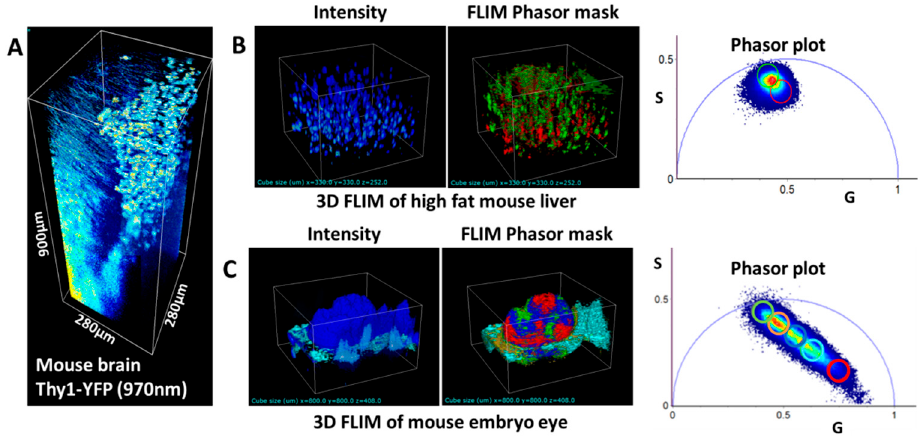
Figure 4. ( A ) 3D reconstitution of a brain section of a transgenic mouse expressing Thy-1-YFP-16 as a markerofneurons. ( B )3Dintensityandfluorescencelifetimeimaging(FLIM)imagesofautofluorescence from liver tissue of a mouse under high fat diet. The phasor plot allows isolation of di ff erent lipids (green and red cursors). ( C ) 3D intensity and FLIM images of a GFP expressing mouse embryo eye. The cursor selections used at the phasor plot enable isolation of di ff erent features, such as collagen layers, GFP cells etc., due to lifetime heterogeneities, which cannot be seen in an intensity